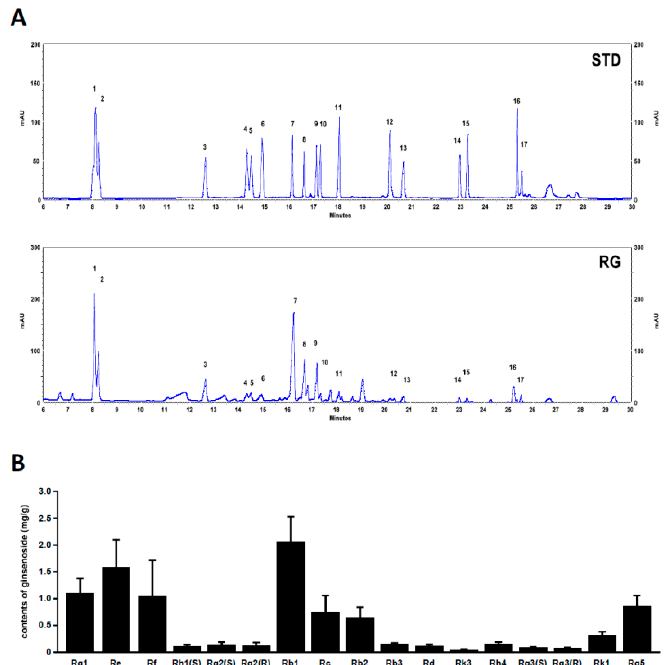
Figure 8. Ultra-performance liquid chromatography (UPLC) analysis of ginsenosides in RG. ( A ) The chromatograms of the standard mixture and RG. Peaks: 1; Rg1, 2; Re, 3 Rf, 4; Rh1, 5; Rg2(S), 6; Rg2(R), 7; Rb1, 8; Rc, 9; Rb2, 10; Rb3, 11; Rd, 12; Rk3, 13; Rh4, 14; Rg3(S), 15; Rg3(R), 16; Rk1, 17; Rg5. ( B ) Contents of 14 ginsenosides in red ginseng (mg / g). Characterization and quantification ginsenosides in RG were conducted using ginsenoside